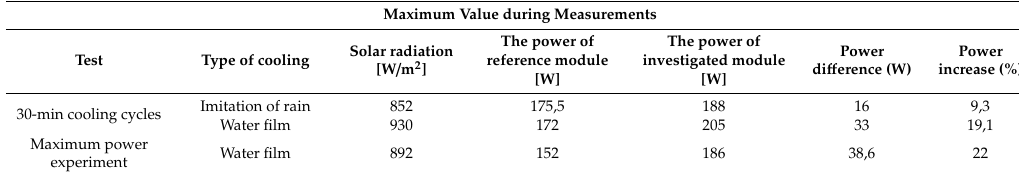
Table 1. Summary of maximum values of modules and their increments.